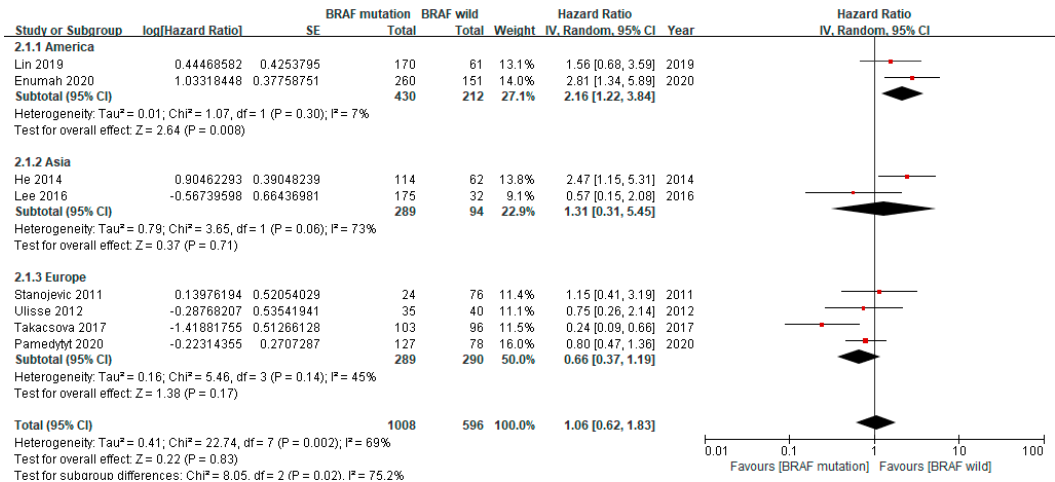
Figure 4. Forest plot of the subgroup analysis according to the geographical region.